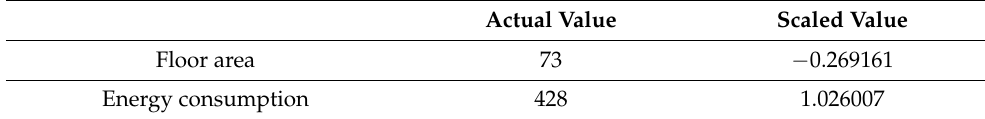
Table 5. Actual versus scaled values.